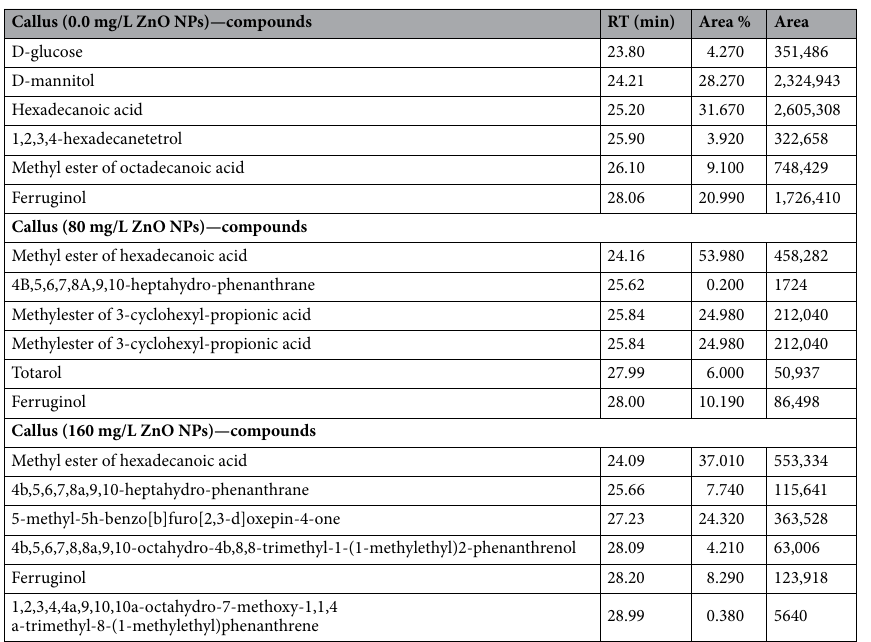
Figure 6. ( a ) Gallic acid standard curve. The standard curve is used to estimate phenolics (gallic acid equivalents) in a 200-mlsample. ( b ) Total phenolic content under different treatments of biosynthesized ZnO NPs. Callus (0.0 mg/L ZnO